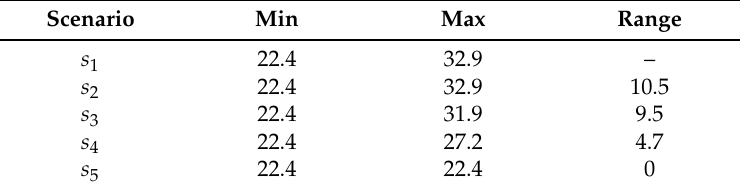
Table 5. Gross margins (Mio. EUR) in the original